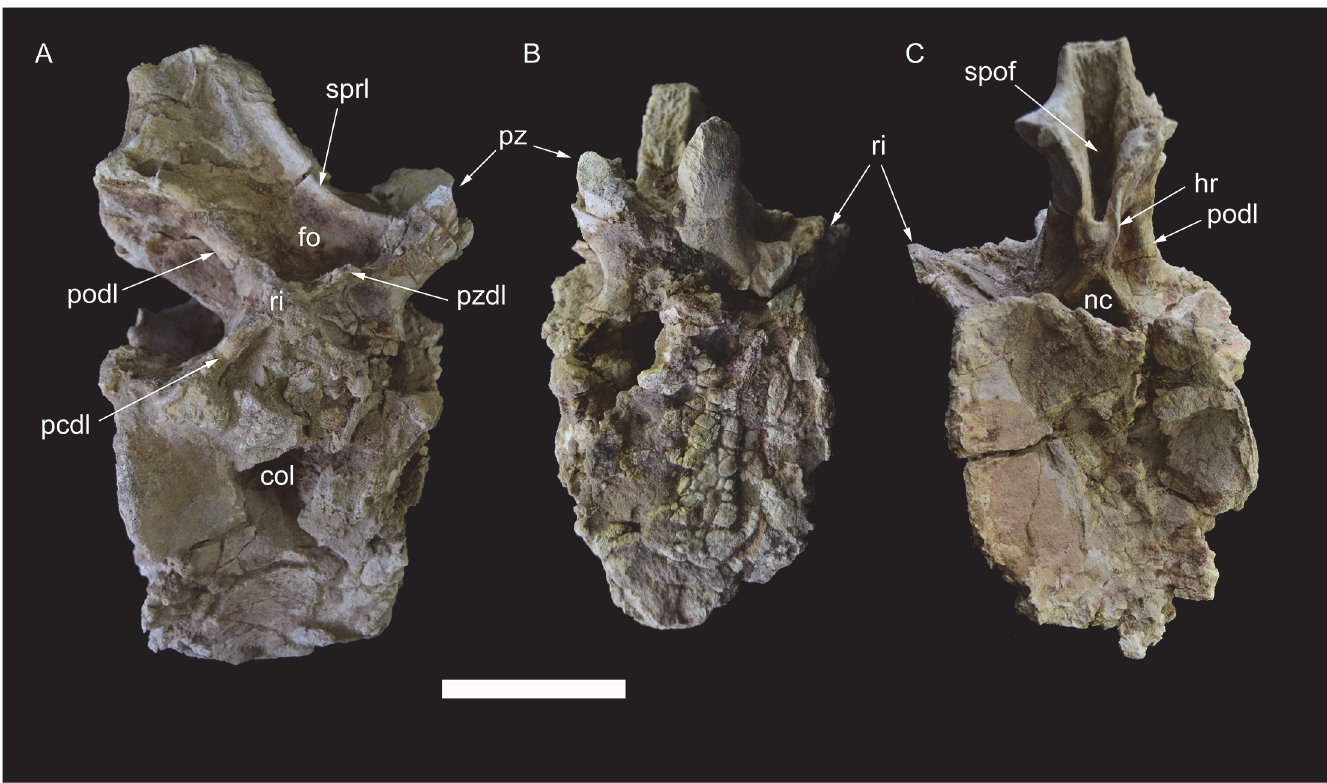
Fig 10. Caudal vertebra 7 of Tataouinea hannibalis . Vertebra in right lateral (A), proximal (B) and distal (C) views. Scale bar: 10 cm. Abbreviations: col, collapsed area; fo, fossa; hr, hyposphenal ridge; nc, neural canal; pcdl, posterior centrodiapophyseal lamina; podl, postzygodiapophyseal lamina; pz, prezygapophysis; pzdl, prezygodiapophyseal lamina; ri, rib; spof, spinopostzygapophyseal fossa; sprl, spinoprezygapophyseal